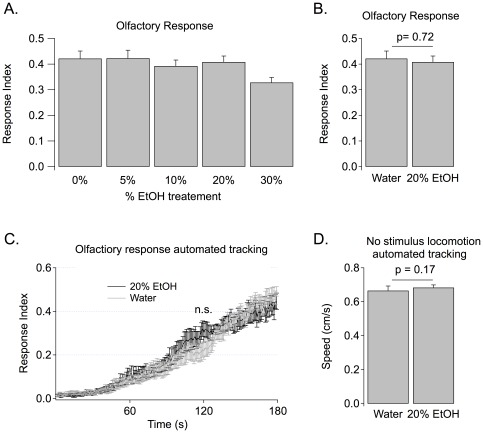
Olfactory response and locomotion are unaffected by ethanol.(A–C) Response indices are shown for larvae when placed in the middle of an agar dish with ethyl acetate on one side and liquid paraffin on the other. The number of larvae in each odor zone was counted after 3 minutes. A. The Olfactory response shows a mild reduction with 30% ethanol treatment but not with 20% ethanol treatment. B. Larvae had been previously submerged for 20 minutes in either pure water or 20% EtOH. No significant difference was seen. C. Automated tracking. Left: Response index over a three-minute period when larvae are being tracked. Larvae had been previously submerged for 20 minutes in either pure water or 20% EtOH. D. Average speed in the absence of a stimulus is shown for larvae during the three minute tracking period. 20% EtOH did not cause a significant reduction in either locomotion speed or olfaction.